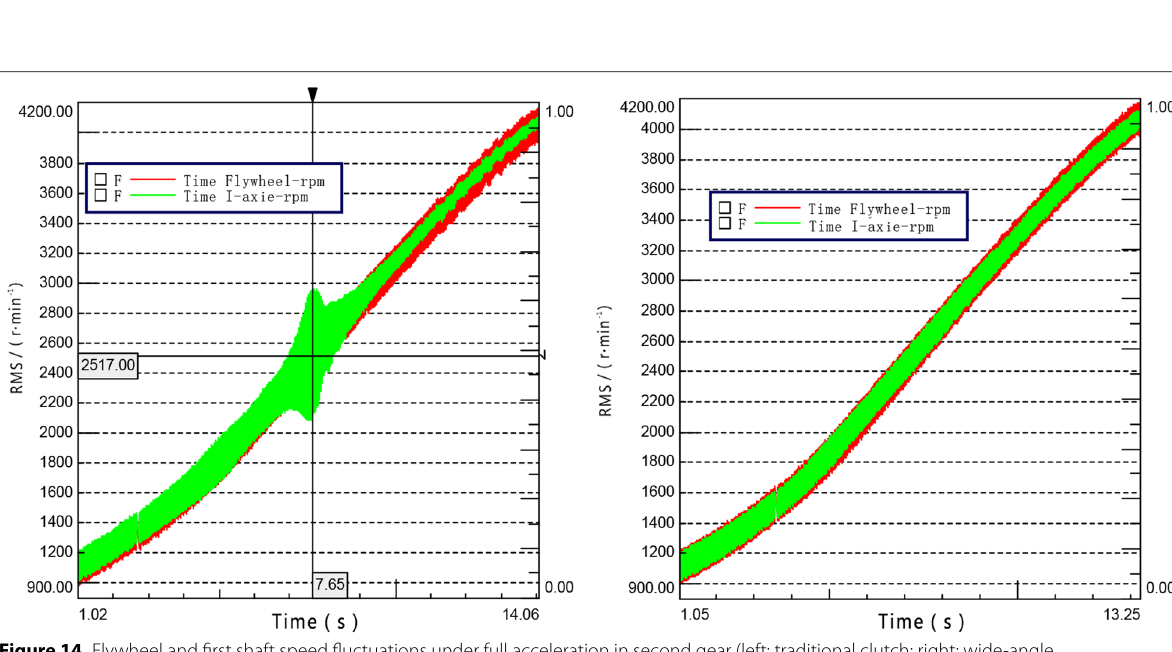
novel clutch (right image), the speed fluctuation attenuated substantially, revealing a prominent damping effect of the clutch. Meanwhile, under a full acceleration in the second gear, as shown in Figure 14 (left image), the first shaft of the gearbox demonstrated resonance at the speed of approxi-